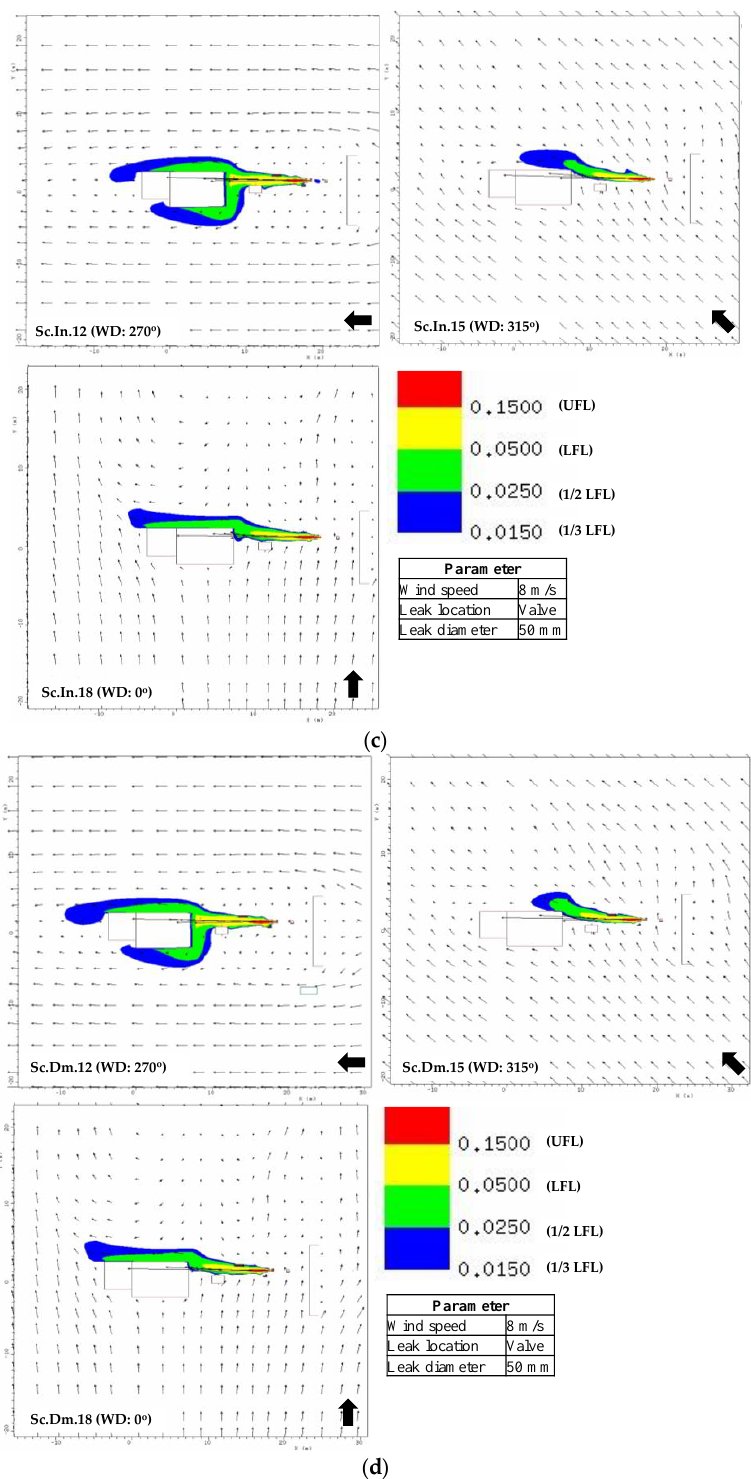
Figure 13. Gas contour plot for the 50 mm valve leak at ( a , b ) 2 m/s and ( c , d ) 8 m/s wind speed. The wind direction is symbolized as an arrow at the right bottom of the plot.